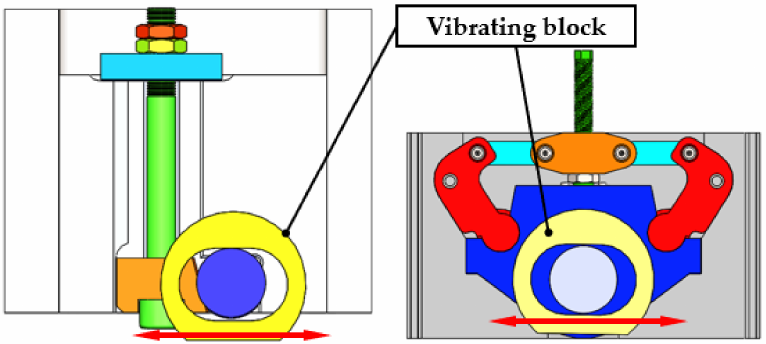
Figure 12. Schematic diagram of the vibration block position. The anti-loosening performance test system of the cutter system is shown in Figure